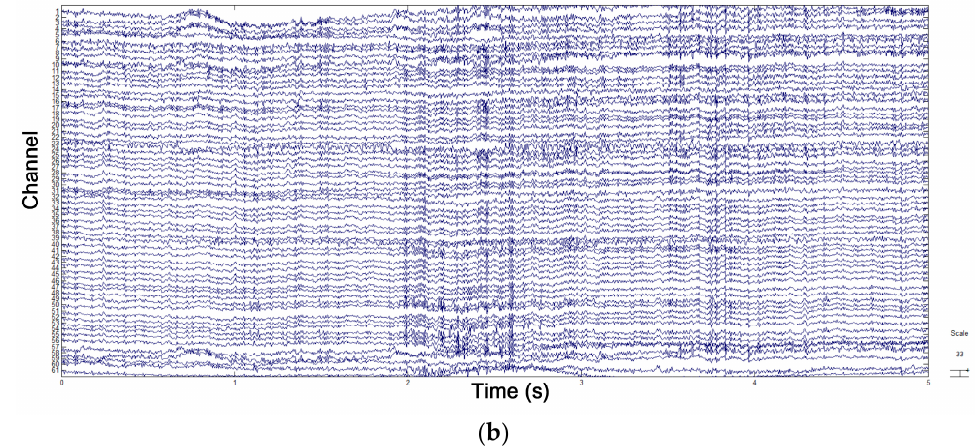
Figure 6. EEG signals before and after the removal of EOG artifacts. ( a ) EEG signals contaminated by EOG artifacts. ( b ) EEG signals without EOG artifacts.